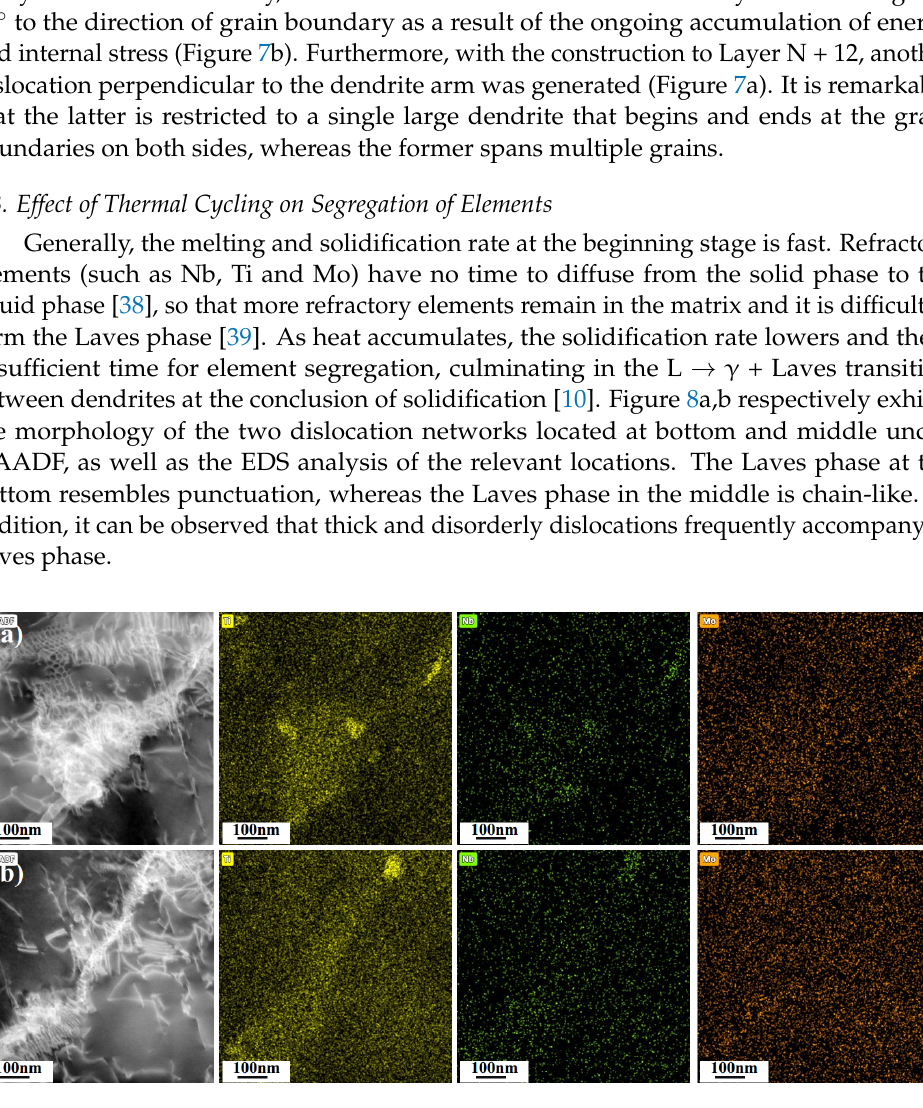
Figure 7. Dislocation distribution of ( a ) Layer N and ( b ) Layer N + 12.